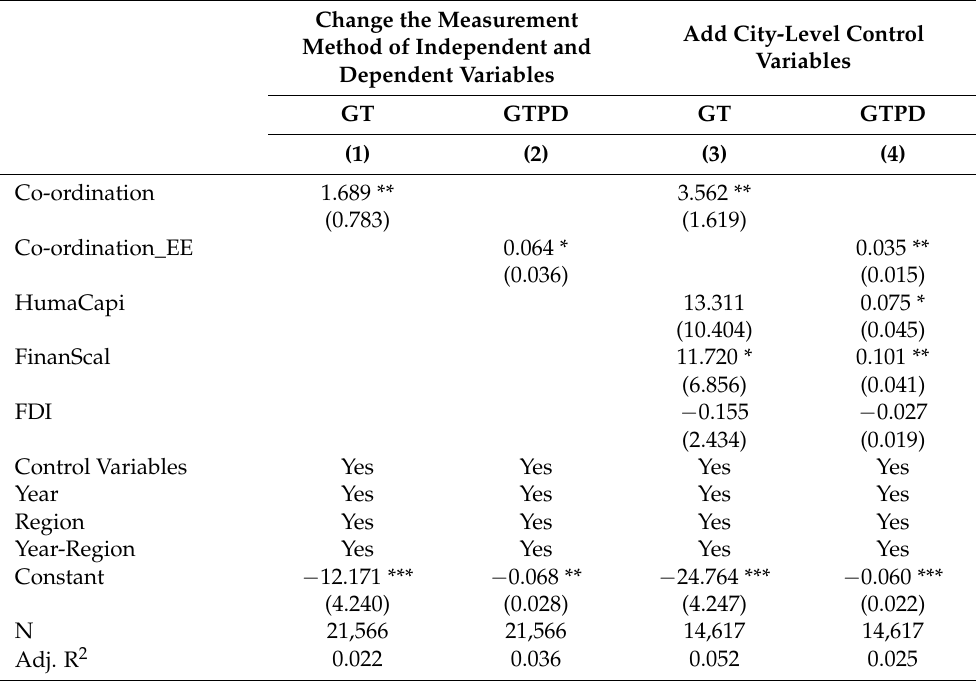
Table 6. Robustness testing of substitution variables and addition of control